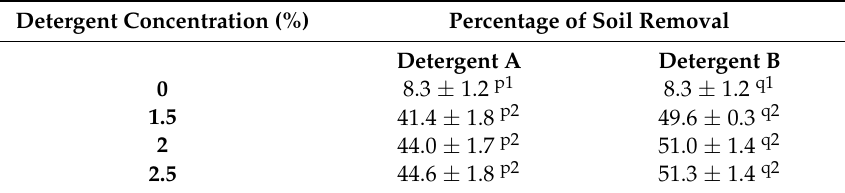
Table 3. Effect of detergent concentration on soil